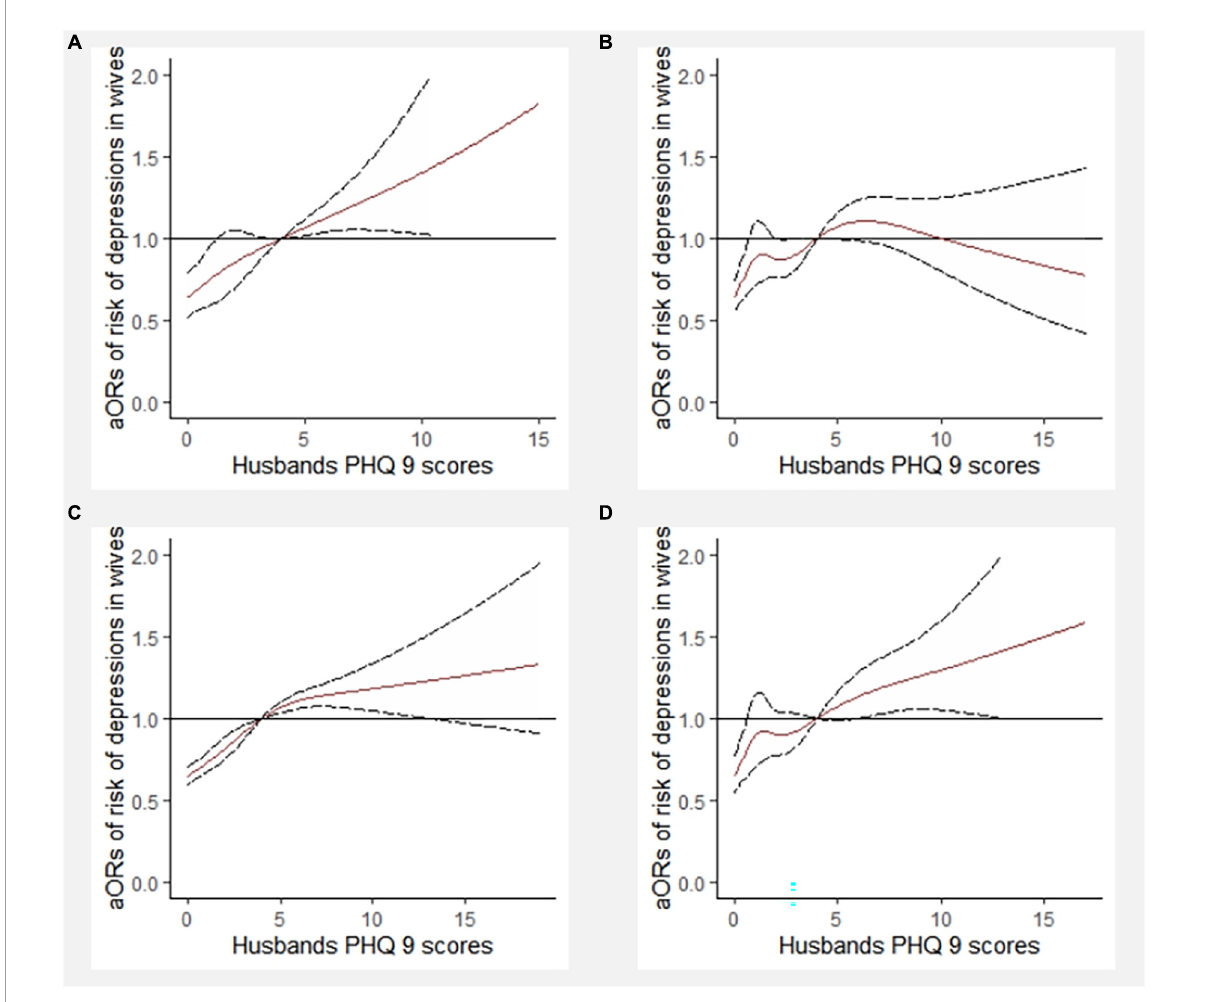
FIGURE7 Dose-response relationship between PHQ-9 scores of husbands and depressive symptoms of wives stratified by socioeconomic status (SES) matching (6 knots). aOR, adjusted odds ratio; PHQ-9, 9-item Patient Health Questionnaire. (A) In the newlyweds with both high-level SES; (B) in the newlyweds with both low-level SES; (C) in the newlyweds with male higher SES; (D) in the newlyweds with female higher